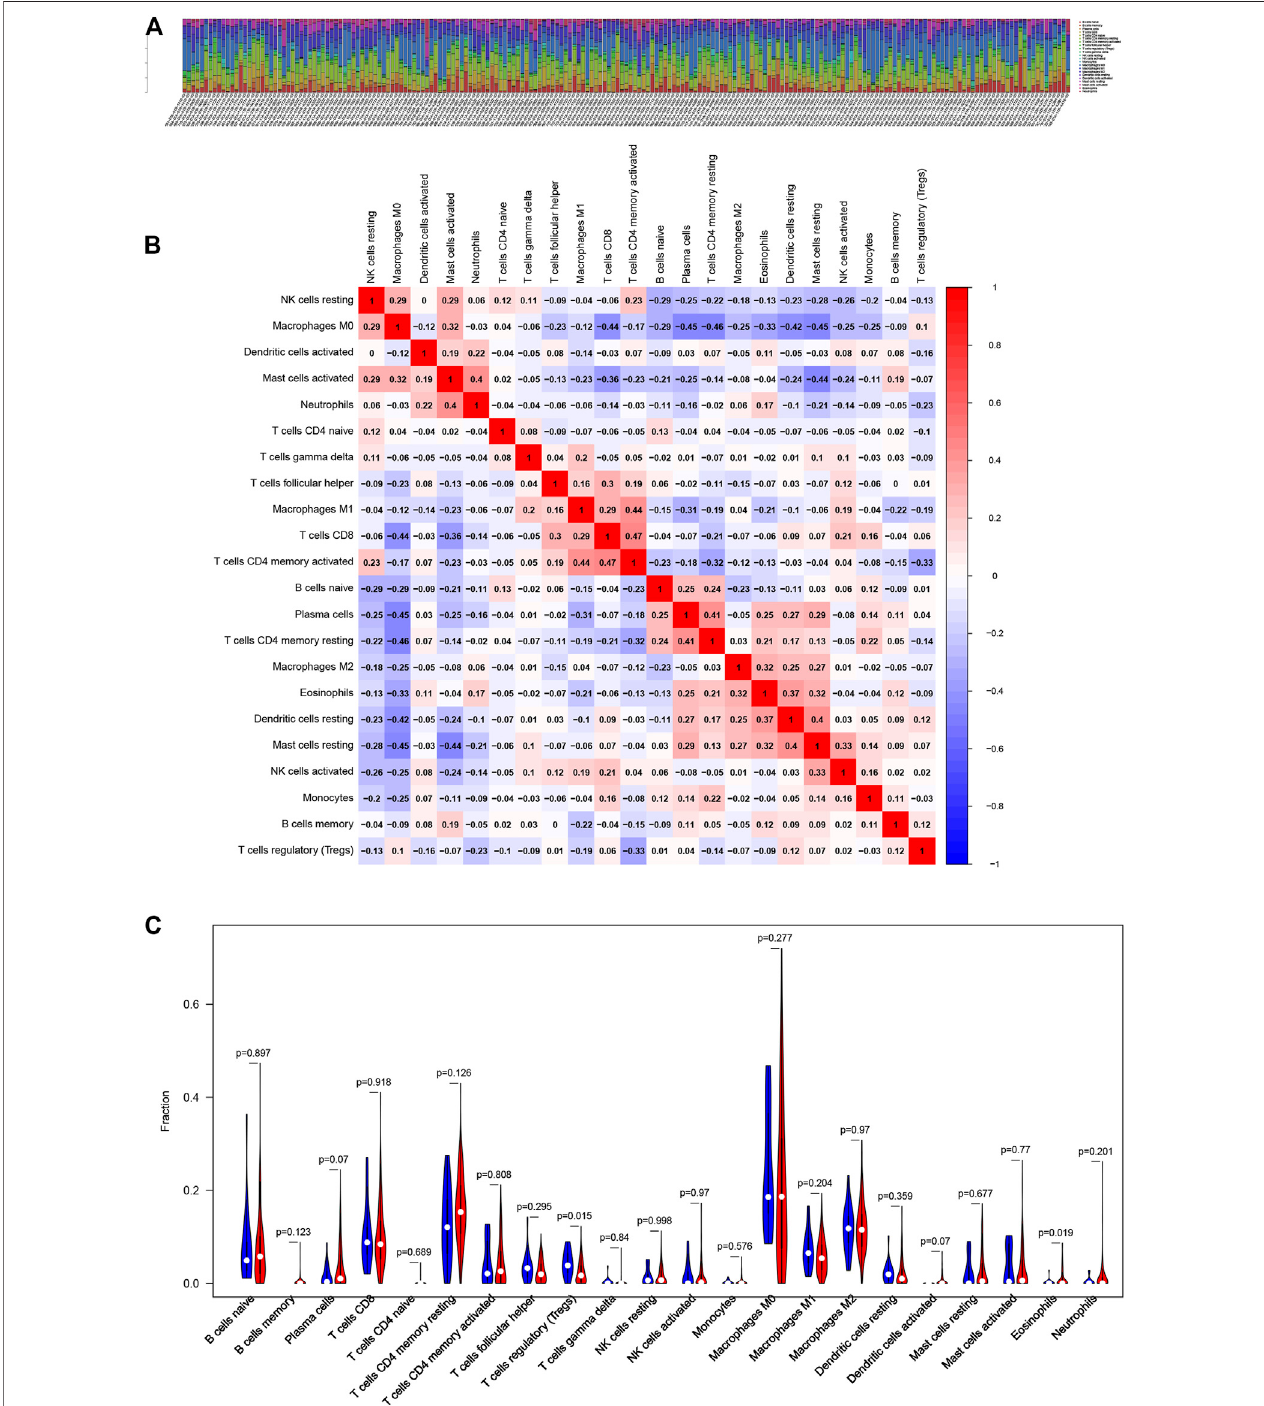
FIGURE7| Associationofironmetabolism-relatedgenesignaturewiththeproportionofTICs (A,B) Barplotandheatmapfortheimmunemicroenvironmentinthe high-risk and low-risk groups (C) Distribution level of 22 types of immune cells in the high- and low-risk groups.